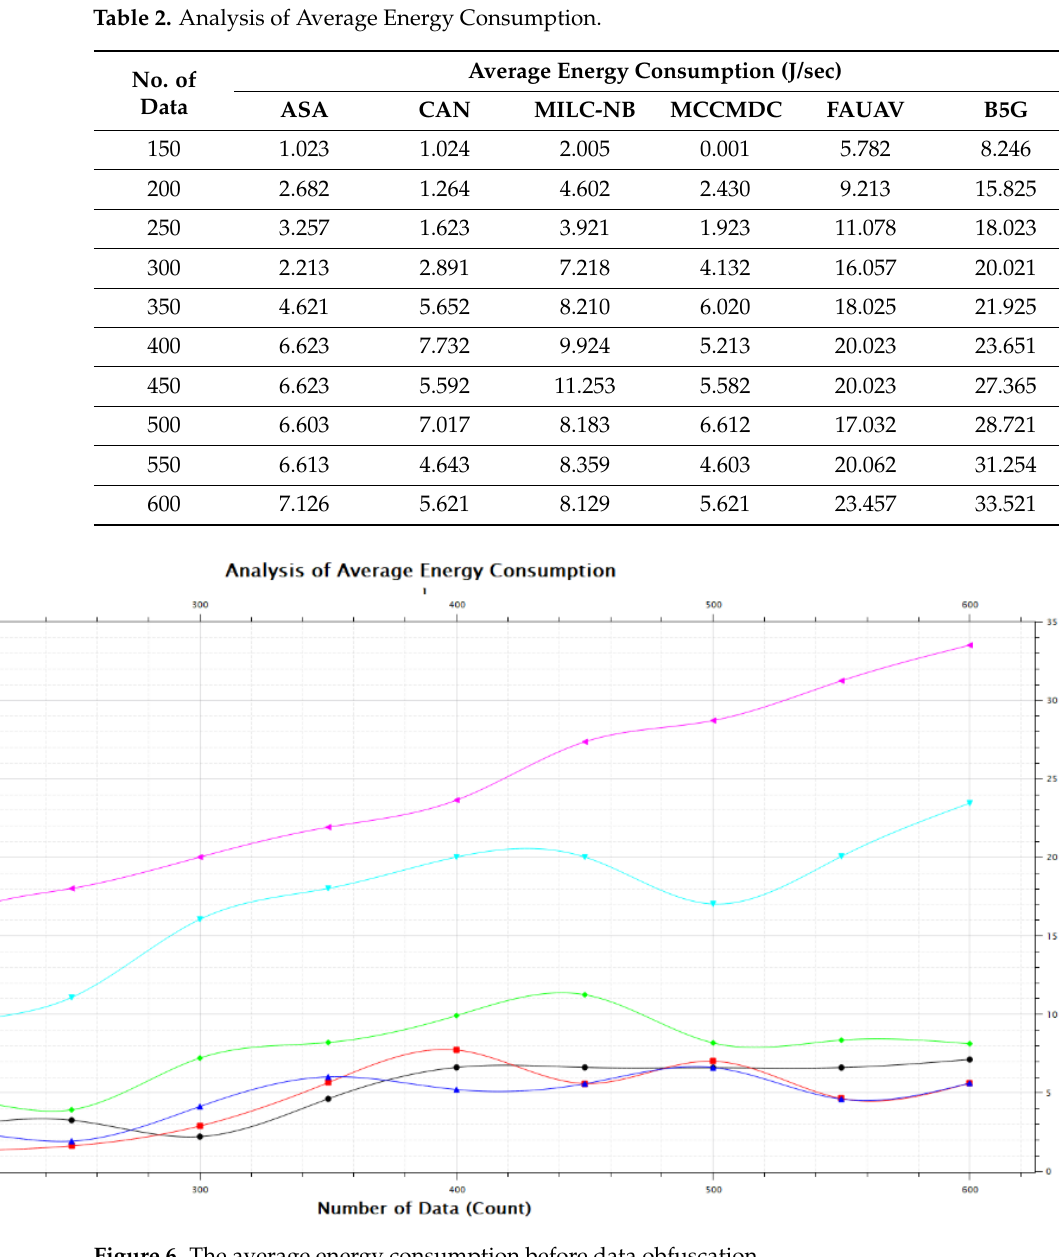
Table 2, Figures 6 and 7 of this research deal with the obfuscation of data which renders sensitive information worthless to harmful actors by replacing it with data that seems to be actual production data. In this era, the Energy Consumption was calculated on the proposed Averaged One-Dependence Estimators (AODE) and SELECT Applicable Only to Parallel Server (ASA). This might be compared with the existing system of Energy